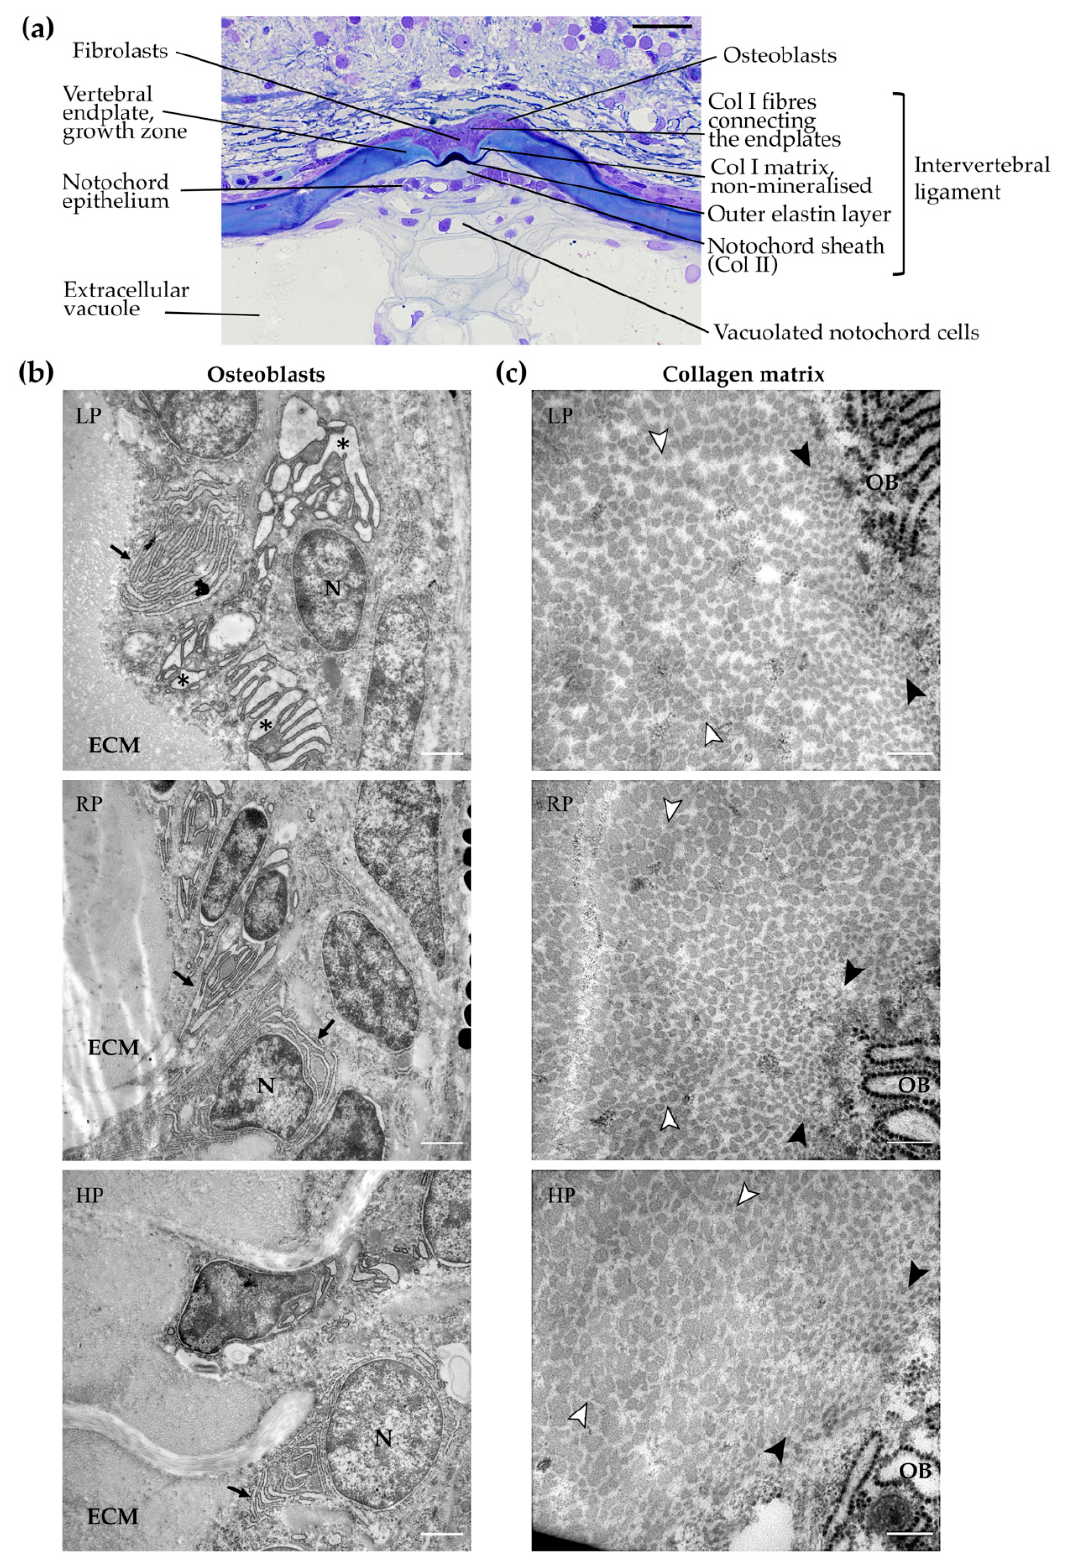
Figure 6. Osteoblasts and collagen type I in the vertebral body endplate growth zone. ( a ) Representative toluidine blue stained semi-thin sagittal section showing internal structures of zebrafish vertebral centra and intervertebral ligament. Vertebral endplates are normally spaced and fully extended in all dietary groups. The notochord sheath is composed of collagen type II (Col II) secreted by the cells of the notochord epithelium, also named chordoblasts. Vertebral bodies are interconnected by the notochord sheath and by collagen type I (Col I) fibres outside the notochord.